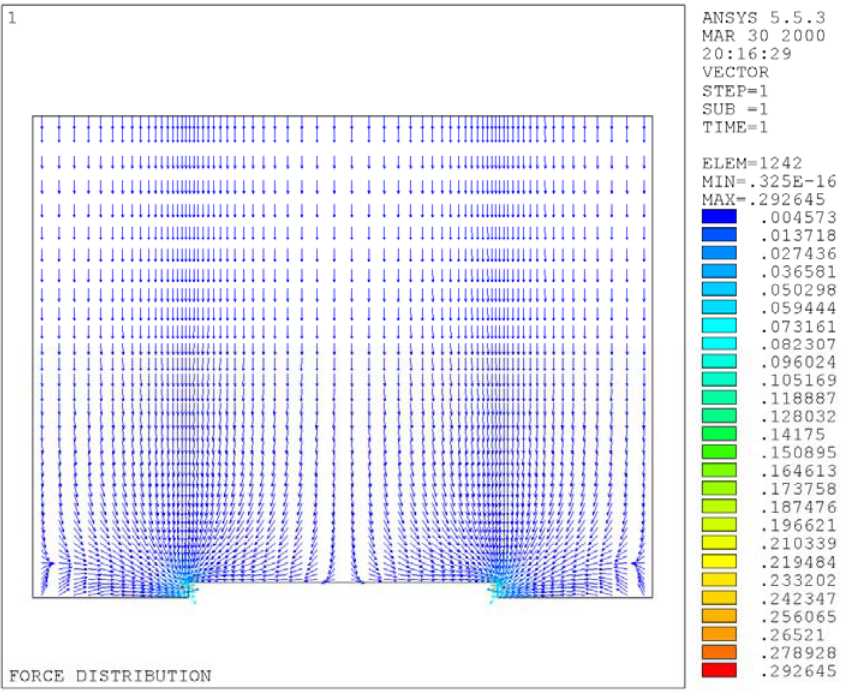
expressed in V 2 μ m − 3 ), around an electrode RMS